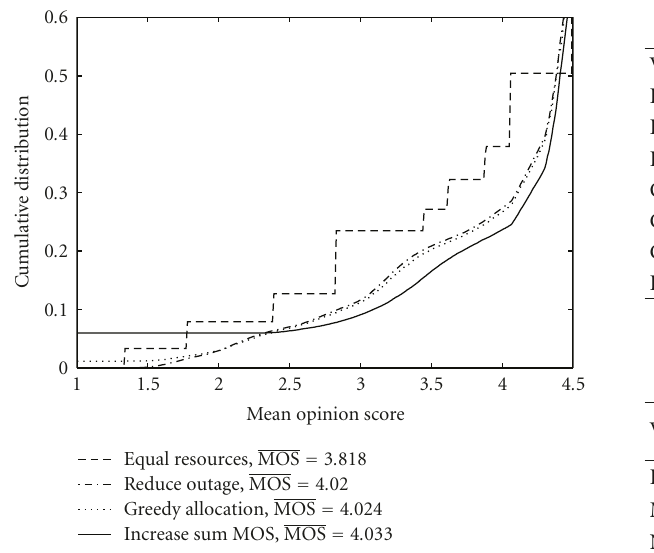
Figure 8: CDF of perceived quality for di ff erent optimization algorithms.